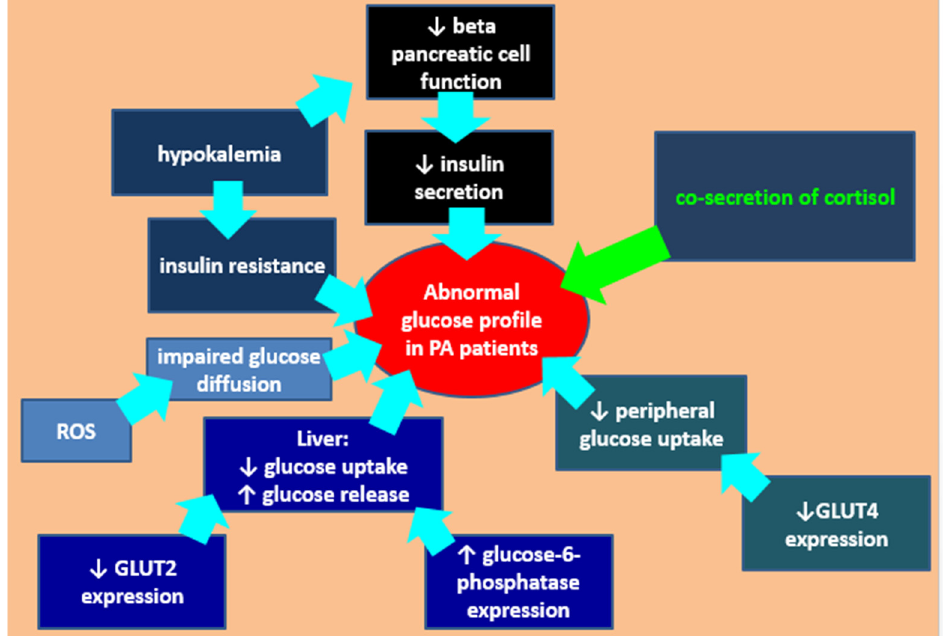
Figure 1. Mechanisms of glucose profile anomalies in patients with Connshing syndrome. In PA patients, apart from cortisol co-secretion, hypokalemia decreases pancreatic release of insulin, and insulin sensitivity in association with reduced glucose uptake by peripheral tissues (liver, skeletal muscle, adipose tissue); aldosterone-induced reactive oxygen species causing endothelial dysfunction impairs glucose diffusion; the decrease of beta pancreatic cell function causes a reduced insulin release; the reduced expression of glucose transporters translates into reduced hepatic uptake of glucose (via GLUT2), with low glucose uptake by other non-hepatic tissues due to reduced GLUT4 expression (please see [59–62]). Abbreviations: PA = primary aldosteronism; ROS = reactive oxygen species; GLUT = glucose transporter.